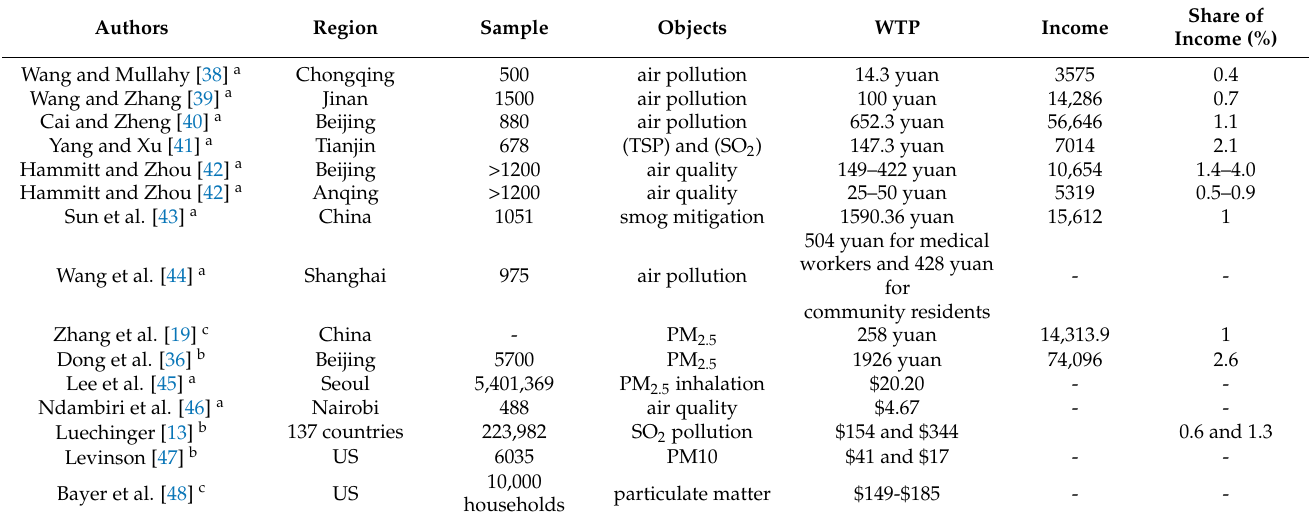
Table A1. Summary of existing empirical studies on the marginal willingness to